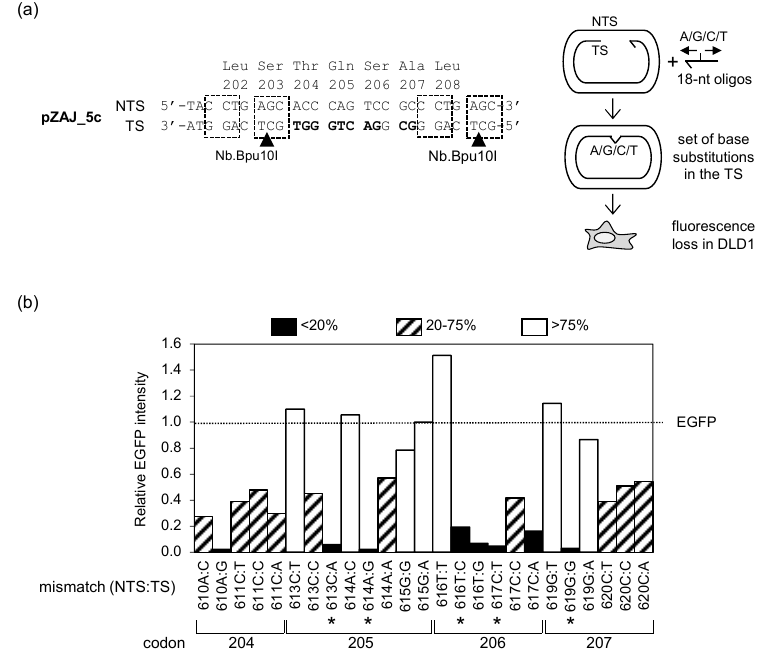
Figure 2. Phenotypic screening of mismatches with the indicated nucleotide substitutions in the TS to identify potential loss-of-fluorescence EGFP mutations: ( a ) Schematic representation of the screening strategy. The pZAJ_5c vector sequence fragment (on the left) shows tandem Nb.Bpu10I recognition sequences (boxes) and the nicking sites in the TS (arrowheads). Nucleotides targeted by single substitutions are marked bold; ( b ) Fluorescence intensities (relative to the original EGFP) measured in the DLD1 cells transfected with constructs containing the specified single-nucleotide mismatches (NTS:TS). Asterisks show candidate mutations selected for further